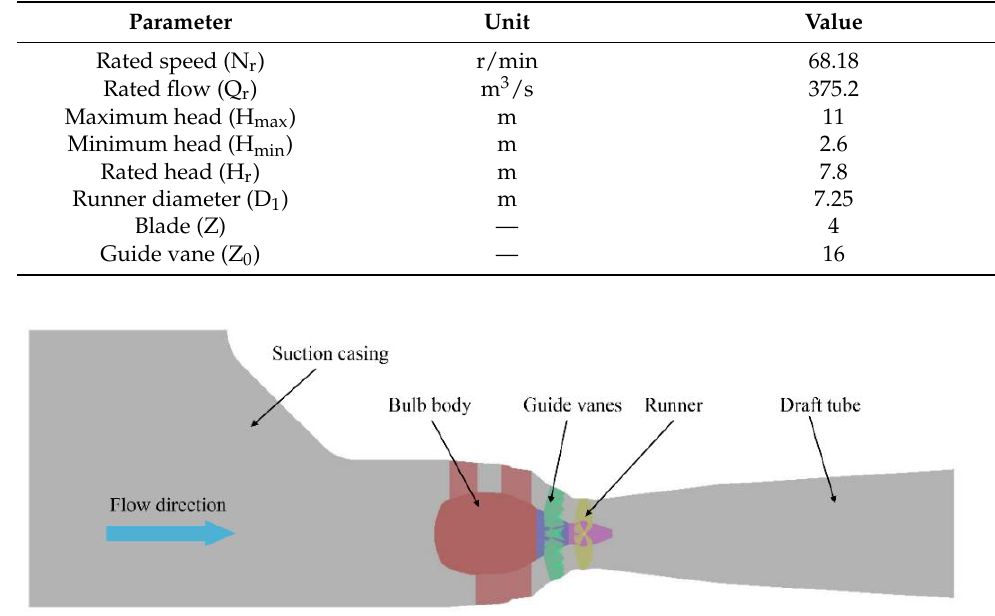
Figure 2. Schematic of full channel of tubular turbine.